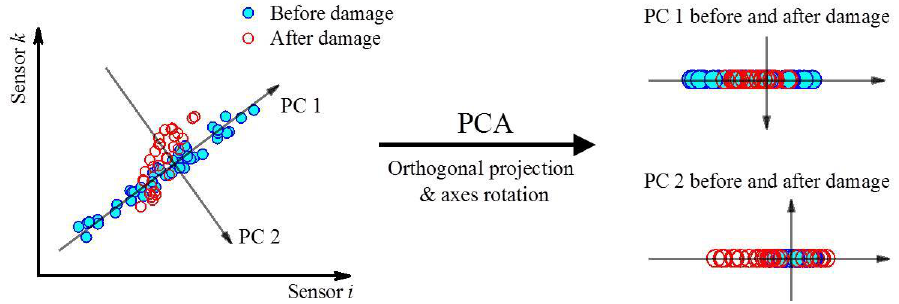
Figure 2. Graphical representation of a two-dimensional PCA. Circles represent strain observations in an undamaged state, and grey dots represent strain observations in a damaged